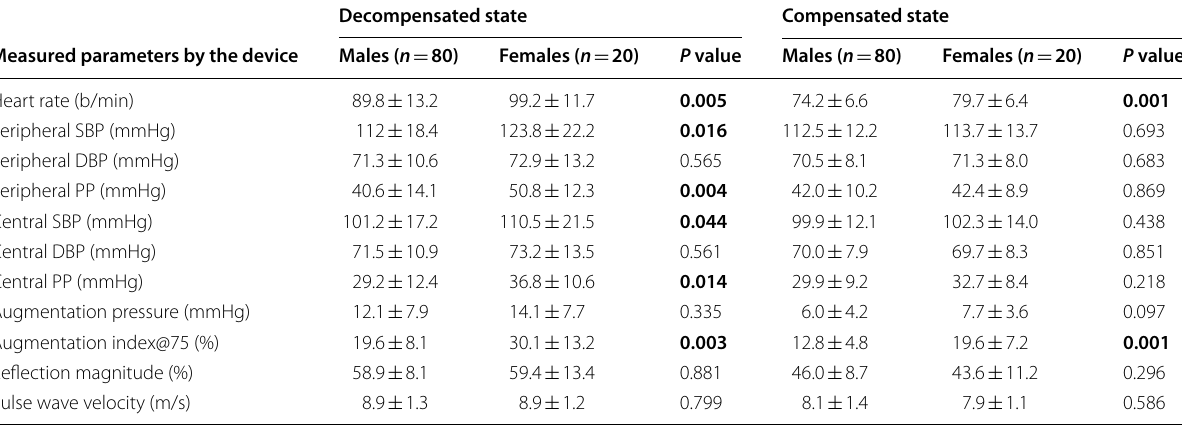
Significant P value (<0.05) is presented in bold Data are presented as mean SD ± DBP, diastolic blood pressure; PP, pulse pressure; SBP, systolic blood pressure Table 5 Comparison between Patients with ICM and Patients with DCM in the decompensated and compensated states